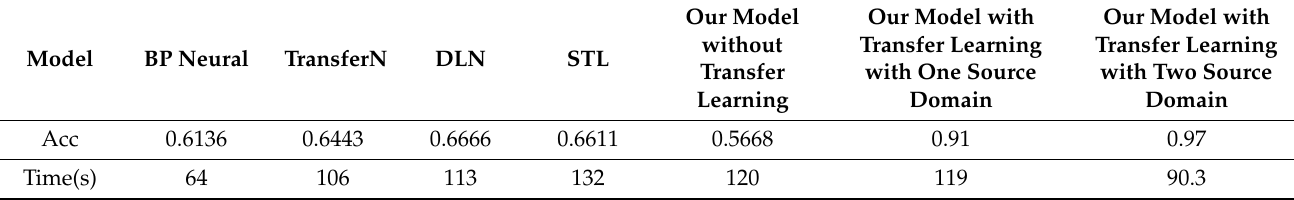
Table 13. Performance